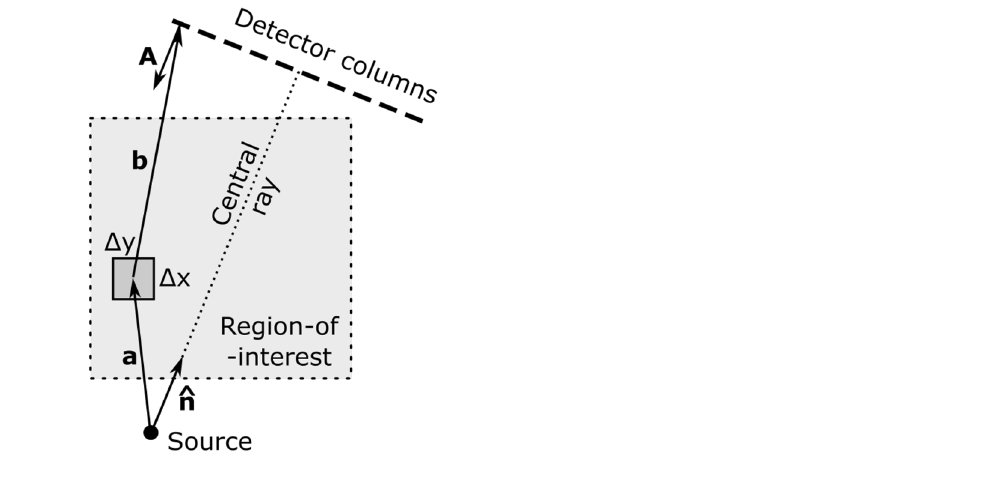
Figure 2. The top view of the scattering geometry. The symbols in the figure are: a b voxel-to-detector vector , (cid:31) x and (cid:31) y are the voxel dimensions in the horizontal plane. The anode plane = that emits X-ray photons is oriented along the unit vector the oriented surface area A in units of mm 2 . The ROI is fixed while the source-detector assembly rotates counterclockwise and records data at SRC